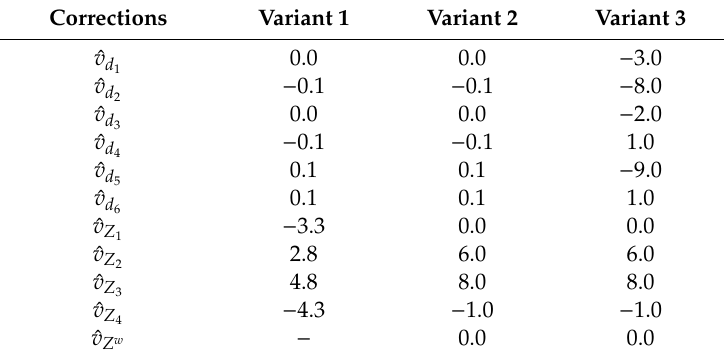
Table 7. Values of corrections for pseudo-observations (in mm).